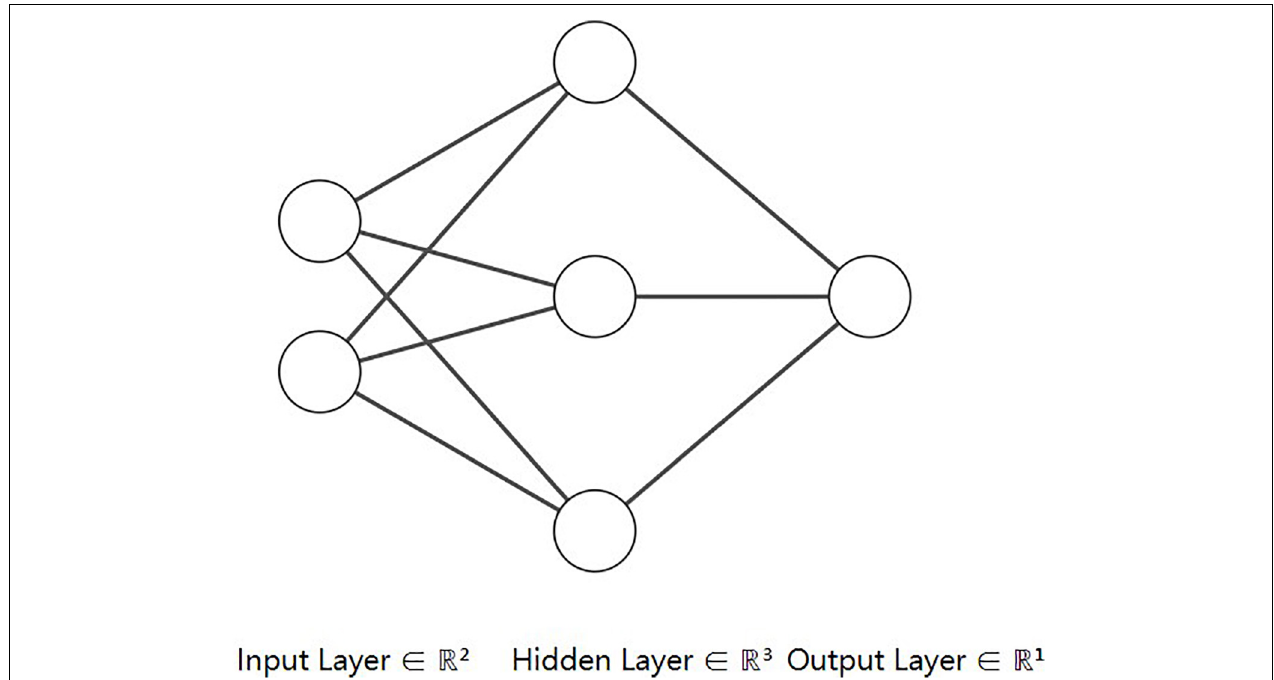
FIGURE 2 | Illustration of neural network architecture.